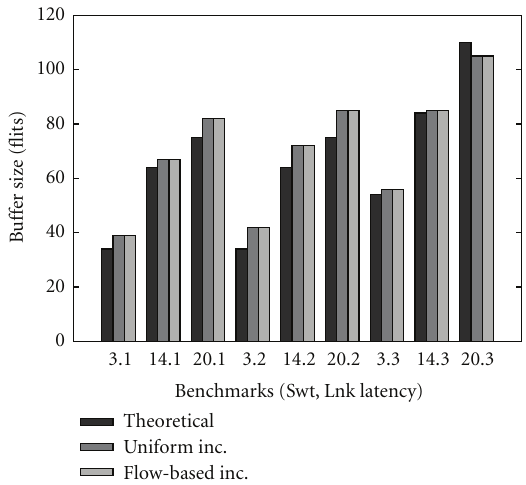
Figure 13: Comparison with theoretical